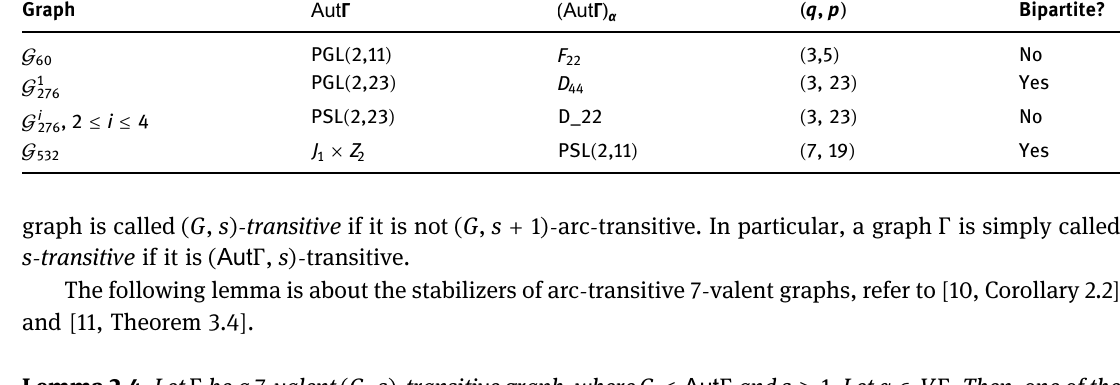
Table 2: Connected 11 - valent symmetric graphs of order 4 pq Graph